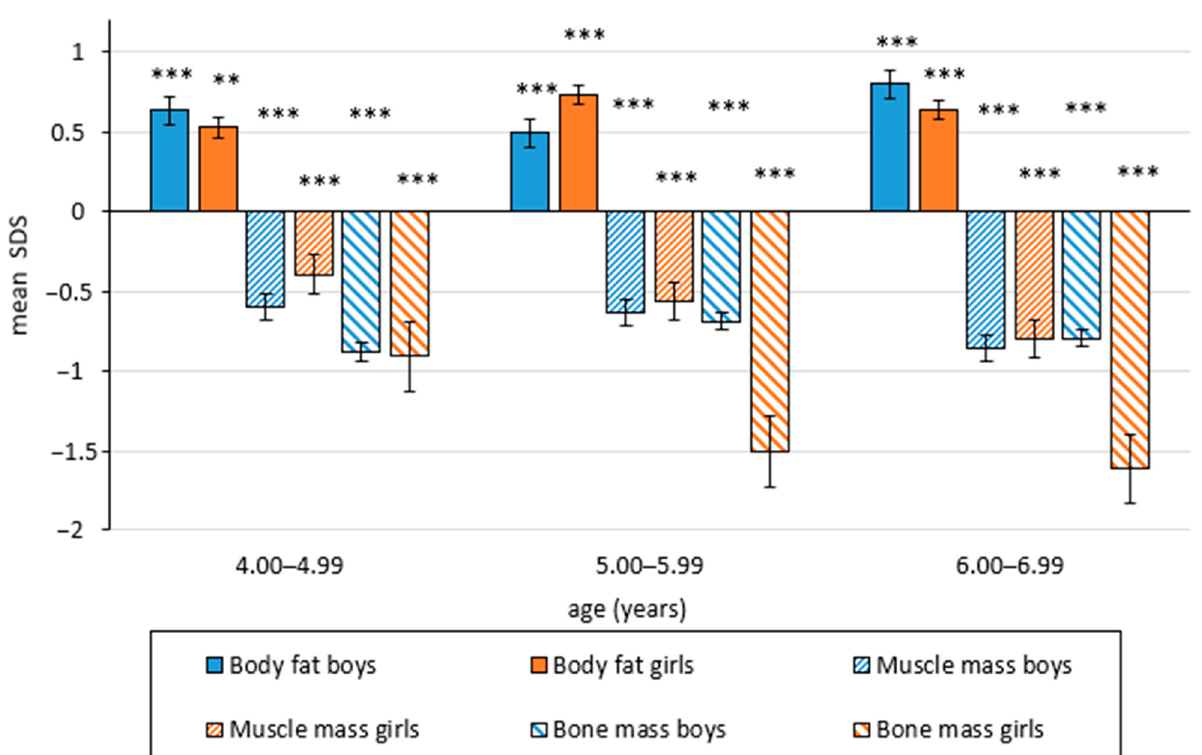
Figure 1. Difference between mean SD-score values of reference and present study sample for each body component (estimated using Matiegka method). Statistical significance level ** p < 0.01; *** p < 0.001.